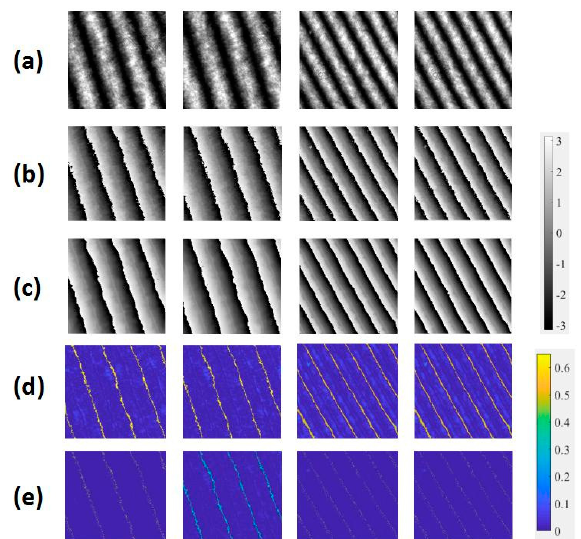
Figure 13. ( a ) Interferograms, wrapped maps calculated from ( b ) four-step phase-shifting method, and ( c ) neural network, and corresponding error maps from ( d ) wavelet transform method, and ( e ) neural network.